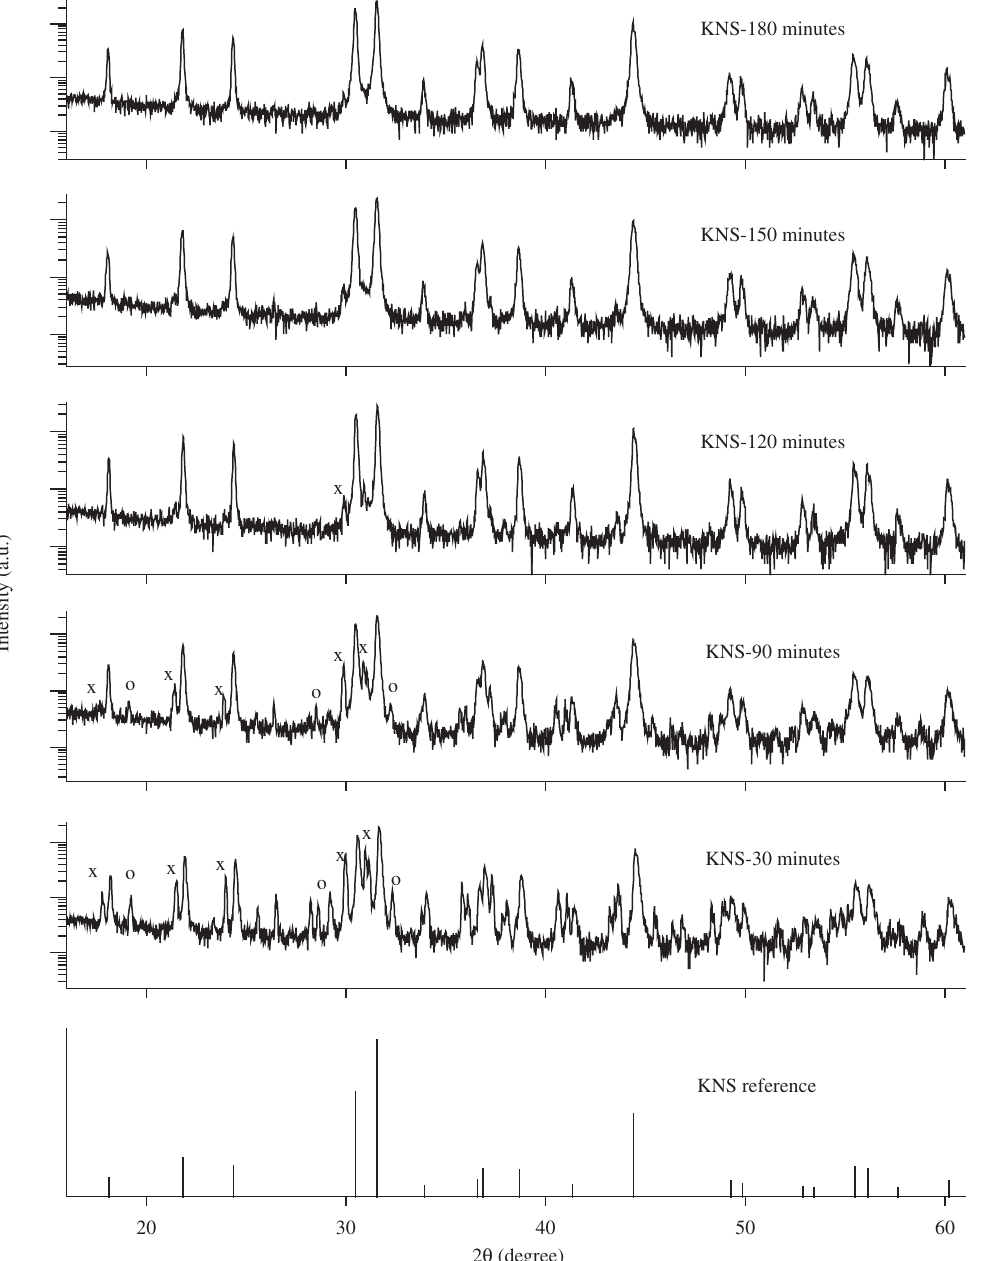
Figure 1. X ray powder diffraction pattern of the KNS powder prepared with low milling times, 30-180 minutes. The vertical bars are associated to the refer- ence pattern of the KNS. The ‘x’ and ‘o’ symbols denote peaks from the K